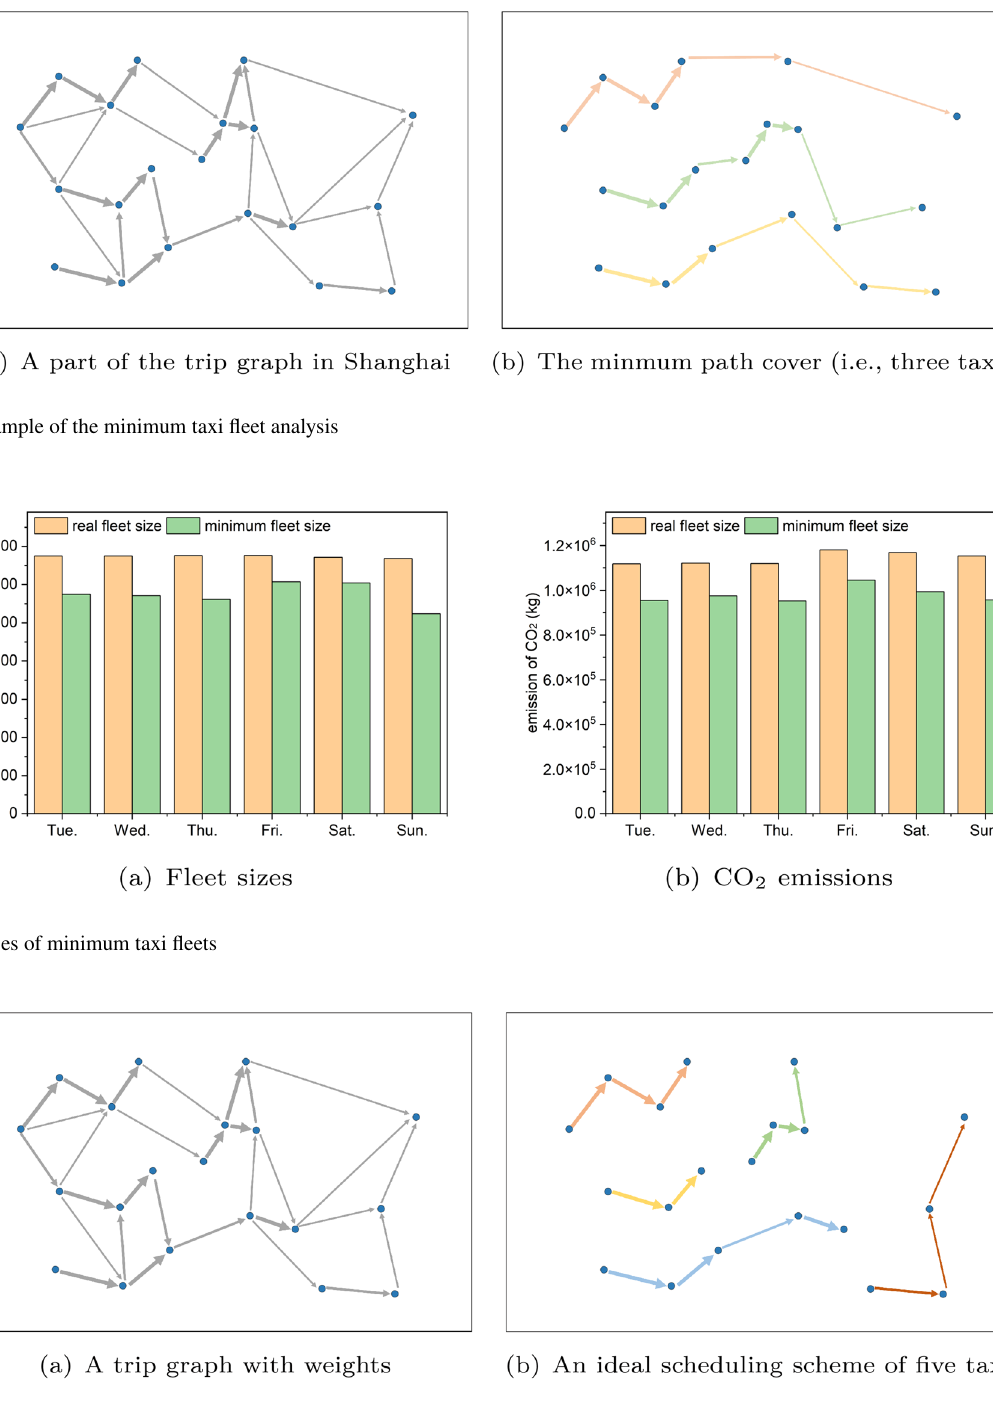
Fig. 24 An example of the minimum total “idle” mileage